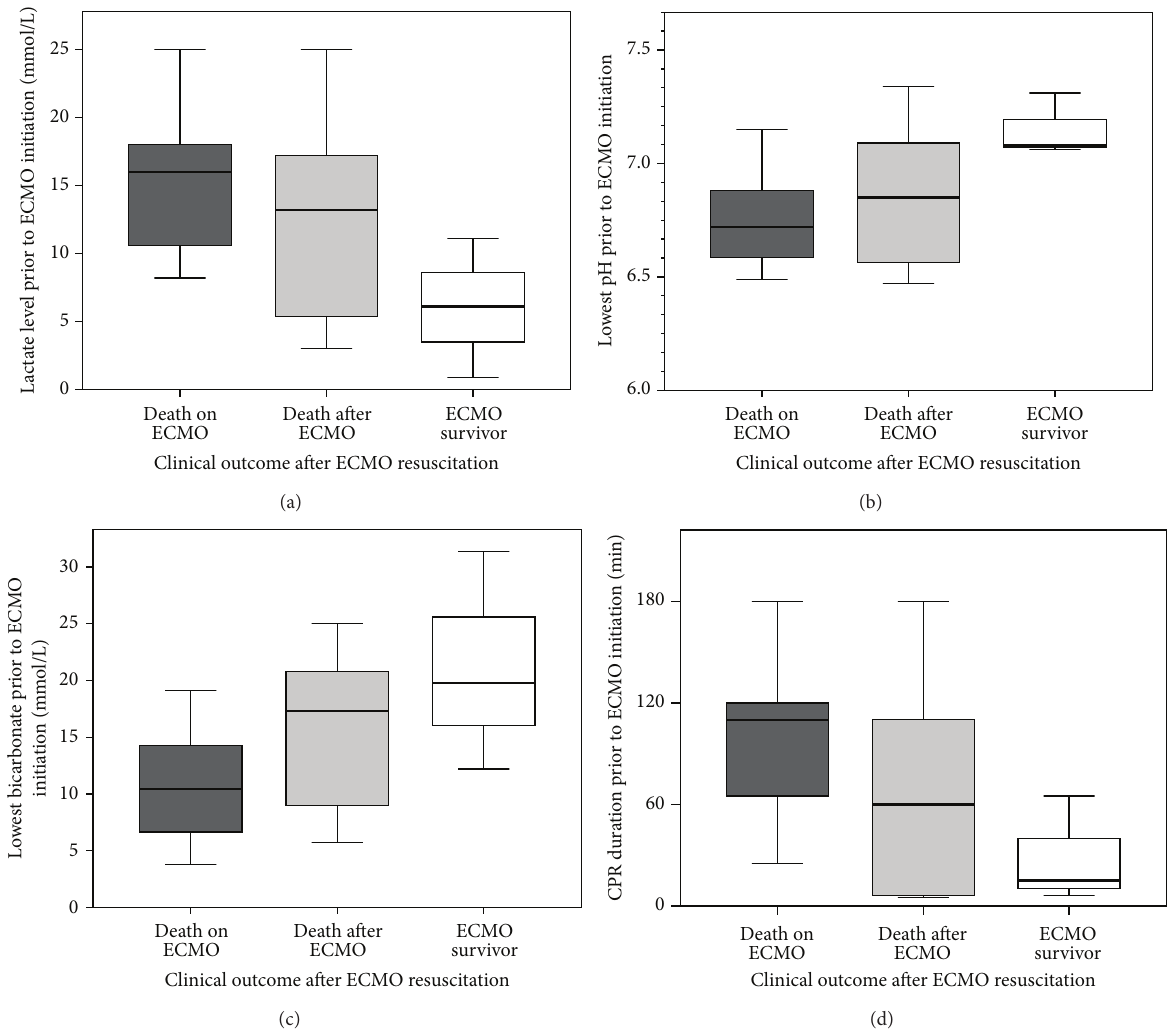
Figure 1: Boxplot of lactate (a), pH (b), and bicarbonate (c) levels before initiation of extracorporeal membrane oxygenation (ECMO) and cardiopulmonary resuscitation (CPR) duration (d) until ECMO initiation, according to clinical outcome (death on ECMO in dark gray, death after successful ECMO weaning in light gray, and survival rate to hospital discharge in